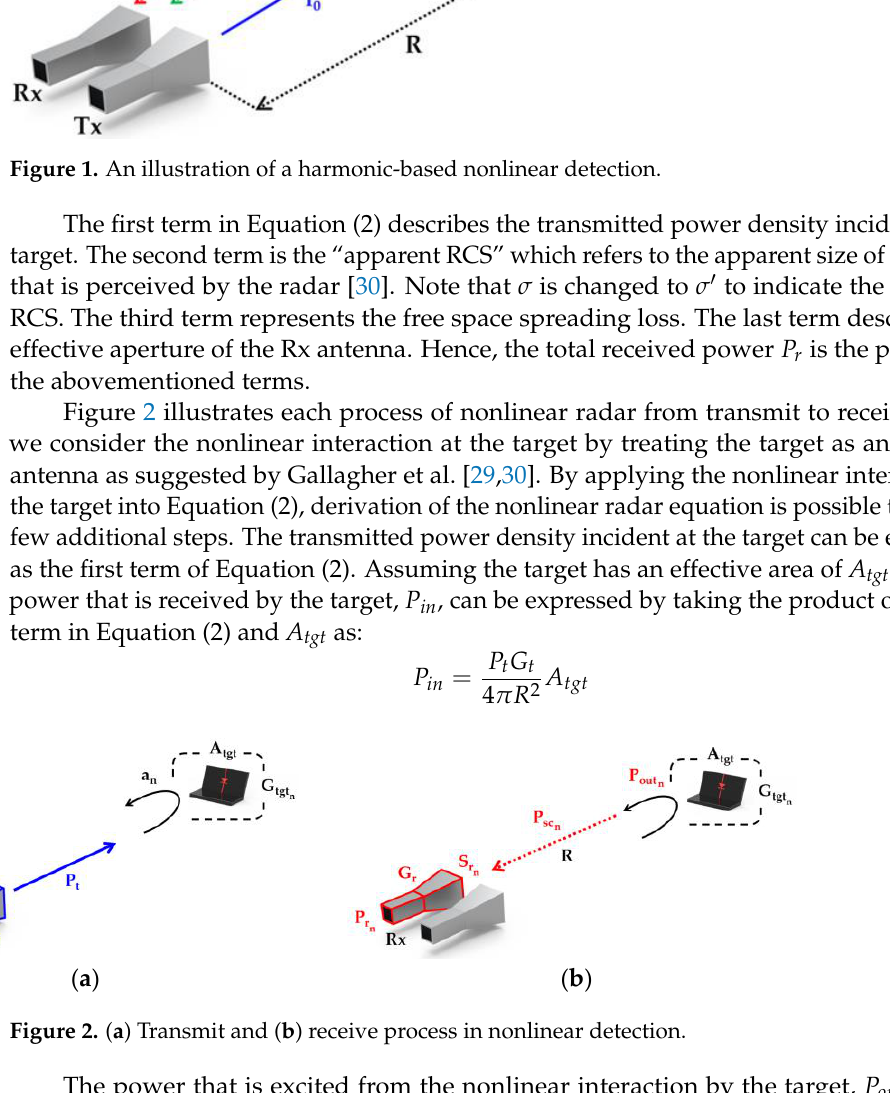
Figure 2. ( a ) Transmit and ( b ) receive process in nonlinear detection.